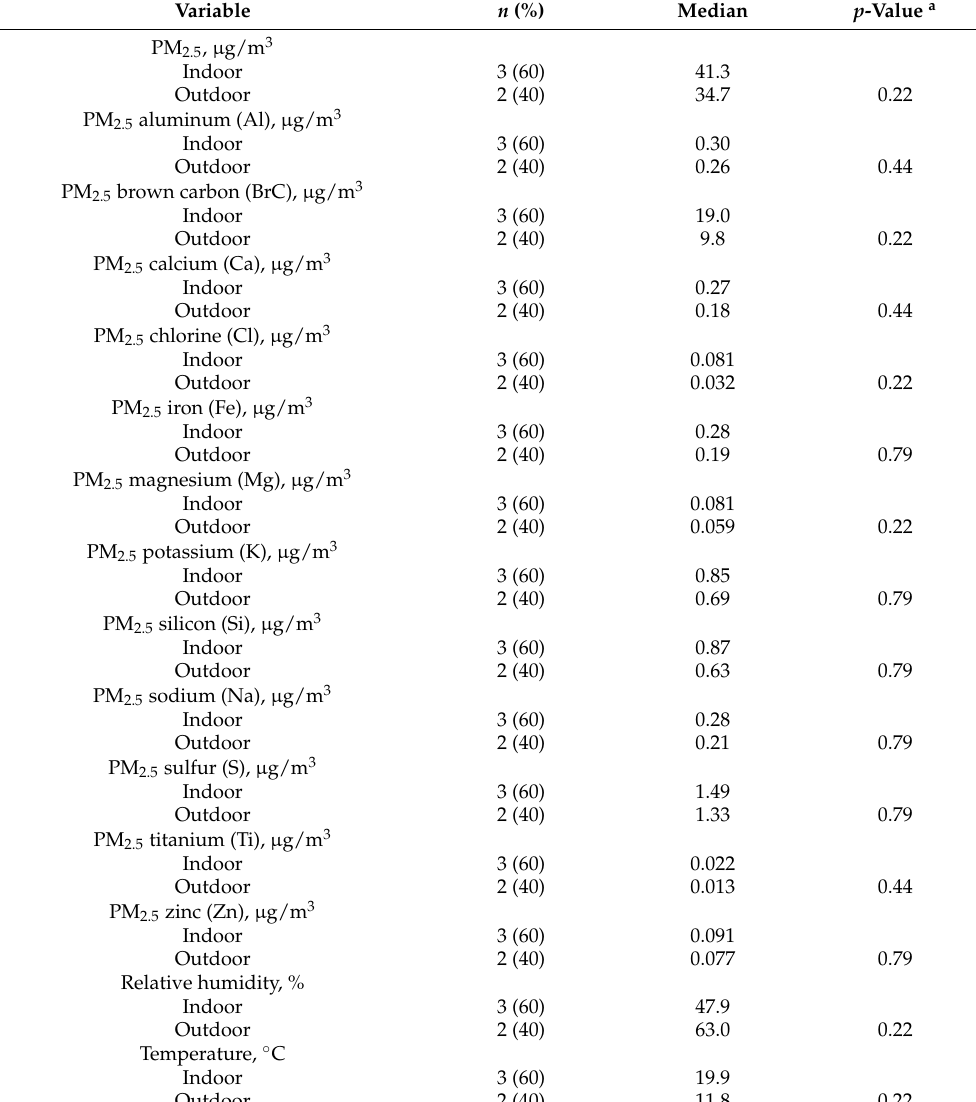
Table 2. Associations between the mean (of the sampling period) and location of samples from teahouses in villages along the Poon Hill circuit trek, Nepal, May 2019. Variable n (%) Median p -Value